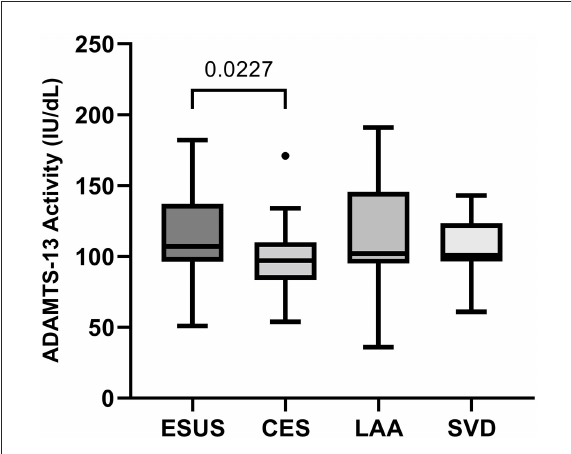
FIGURE1 Comparison of ADAMTS-13 activity between stroke etiologies in cohort 1. CES, cardioembolic stroke due to atrial fibrillation; ESUS, embolic stroke of undetermined source; LAA, large-artery atherosclerosis; SVD, small vessel